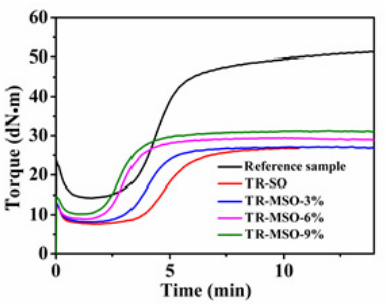
Figure 3. Vulcanization characteristics curve of tread rubber with different plasticizers. Table 3. Vulcanization characteristic of tread rubber with different plasticizers.